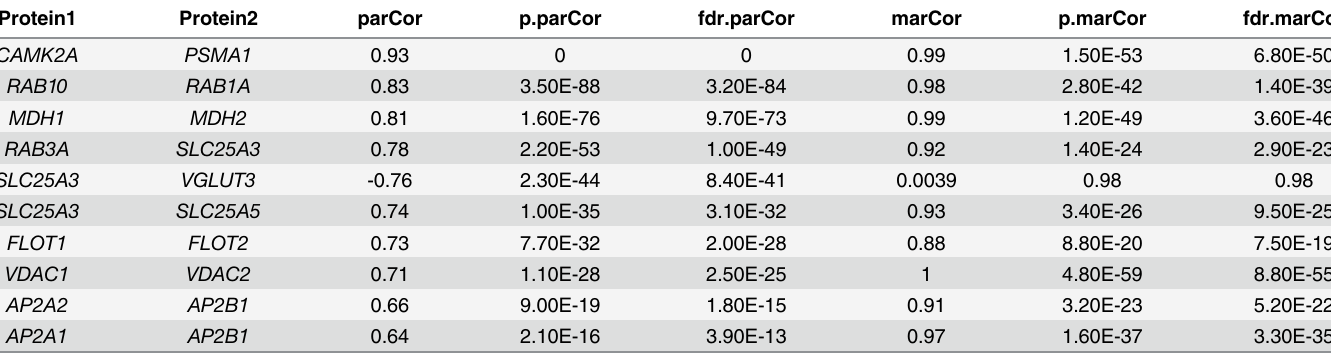
Table 3. Top 10 pairs of proteins with significant partial correlations from the AD